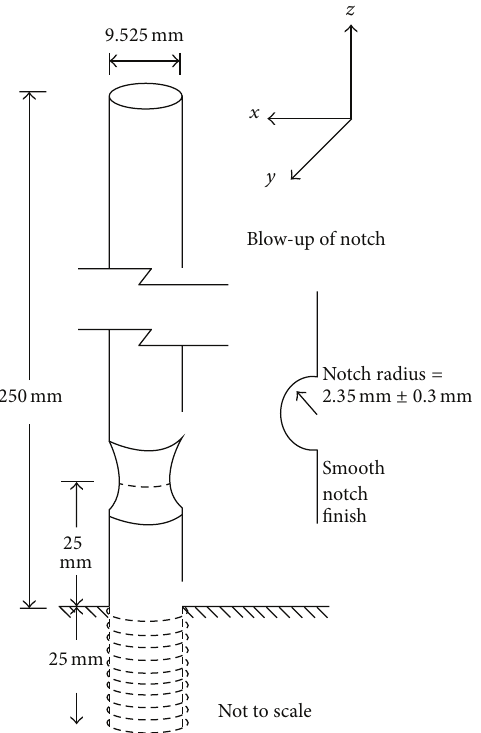
Figure 6: Dimensions of samples tested by Whiteman and Burman